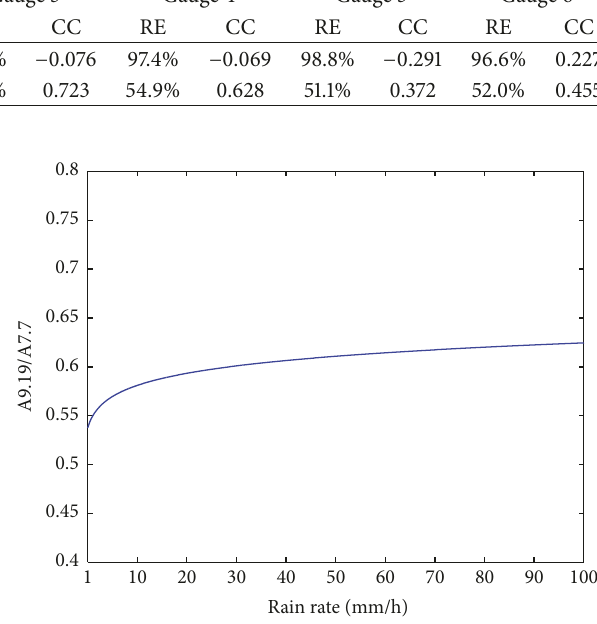
Figure 14: Relationship between specific attenuation due to rain at 9.19 GHz and